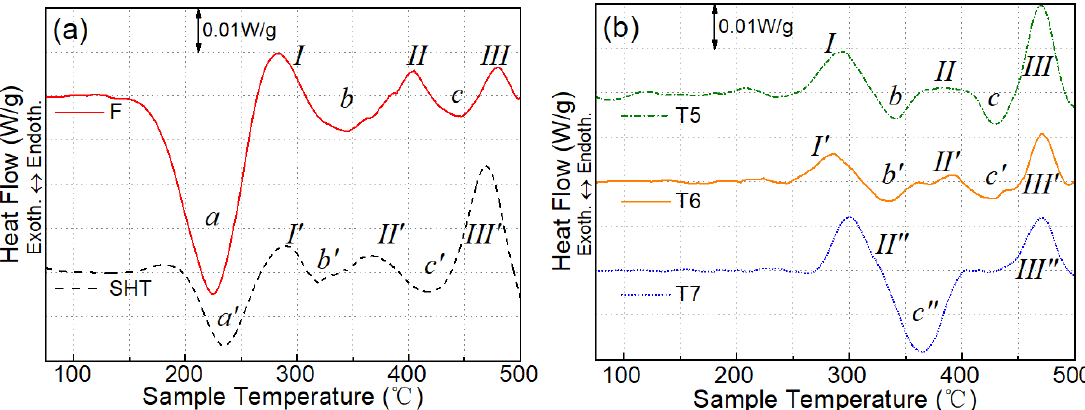
Figure 2. DSC heating curves of AlSi10Mg0.3Mn alloy subject different treatments: ( a ) F and SHT; ( b ) T5, T6, and T7. Table 3. Summary of DSC characteristics of the various tempers of the AlSi10Mg0.3Mn